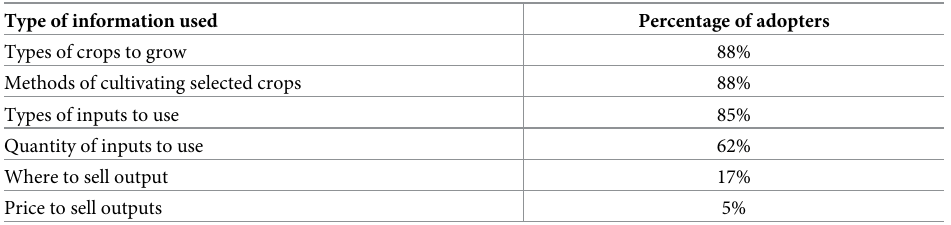
Table 1. Types of information used by digital extension service